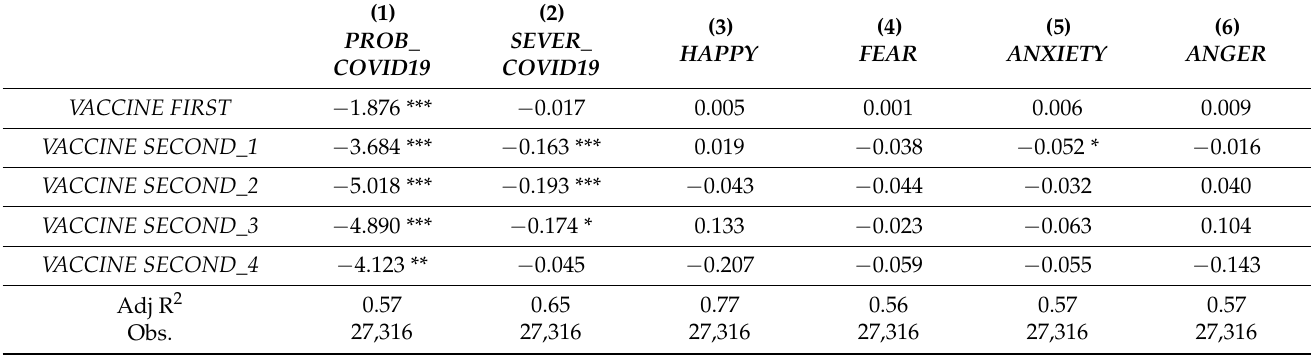
Table 5. FE model: Dependent variables are perceptions of COVID-19 and mental health. Male sample.